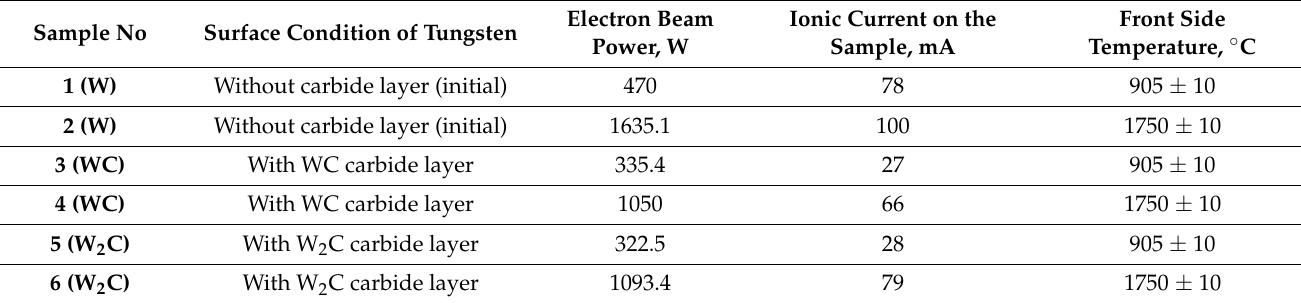
Table 1. Parameters of experiments on the effect of helium plasma on tungsten.